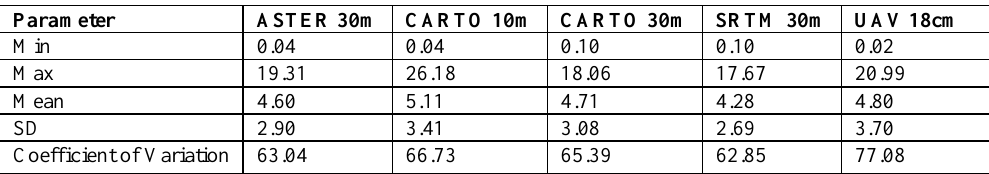
Table 2: LS factor statistics with slope exponent constant